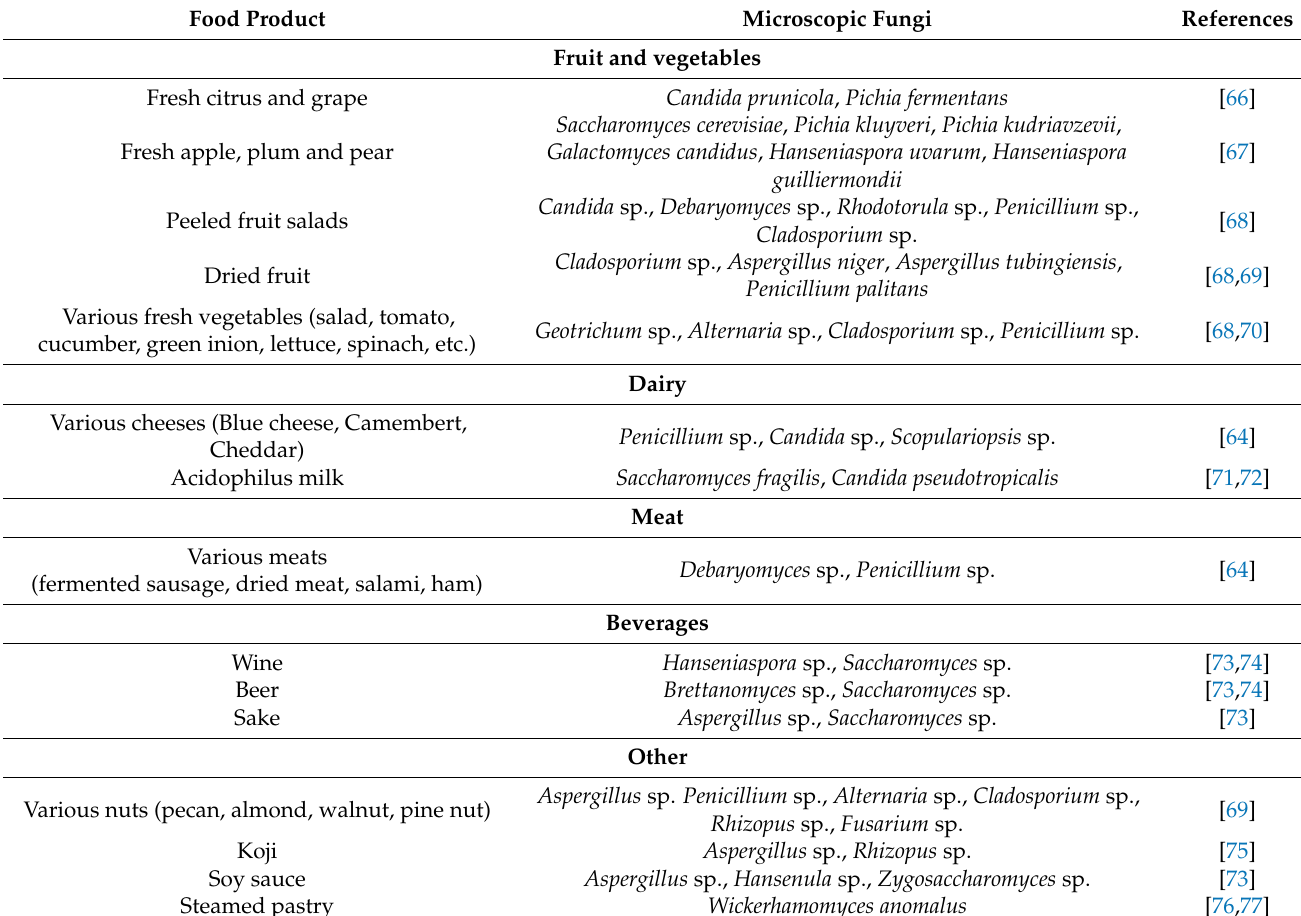
Table 2. The list of food products colonized or contaminated by food-borne microscopic